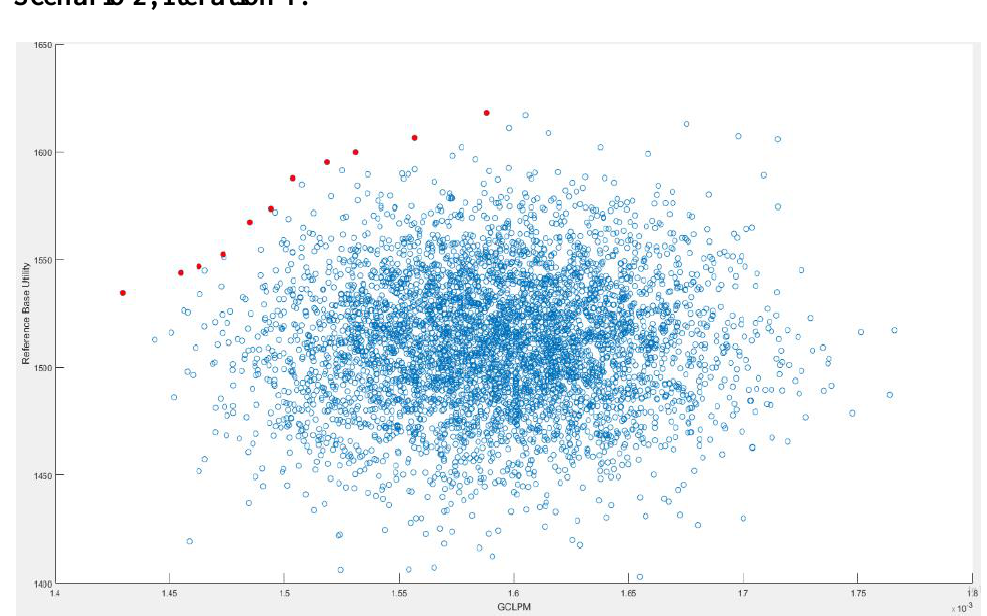
Figure 6. The Result Of Investigation Of 5,000 Different Portfolios In First Iteration Of Scenario 2